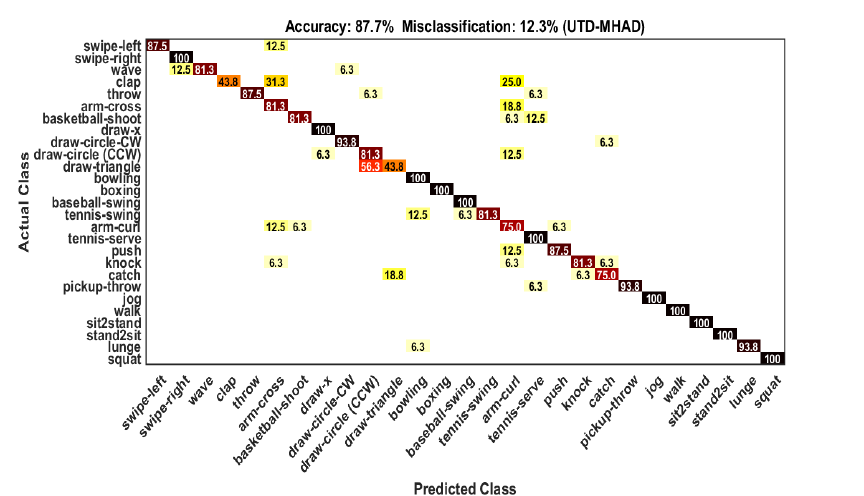
Figure 6. Confusion matrix on the UTD-MHAD